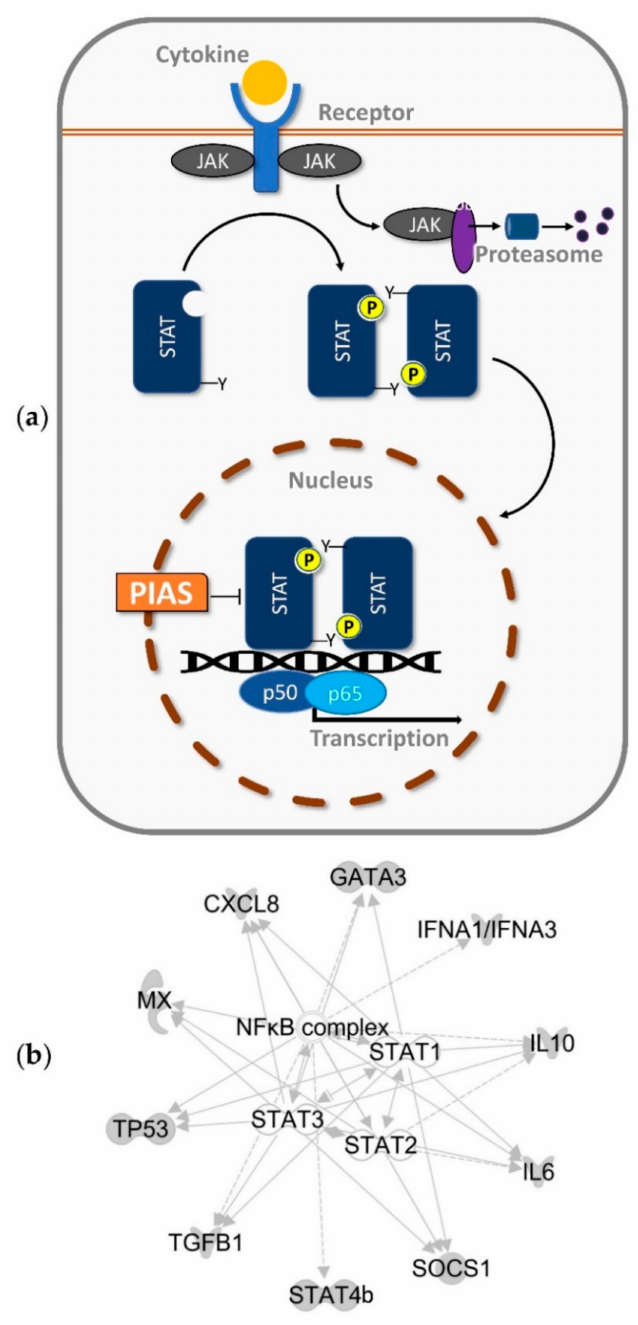
Figure 1. ( a ) Regulation of STAT/NF- κ B-mediated pathways via PIAS; ( b ) target genes of the STAT/NF- κ B-dependent